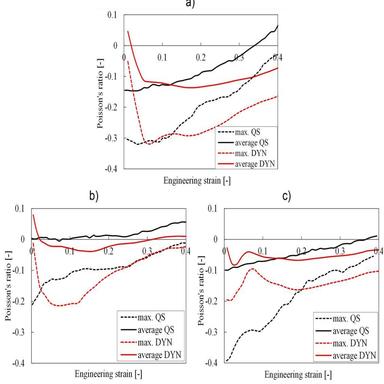
Maximum and average Poisson's ratio to engineering strain relationships for a) ACS_V1, b) ACS_V2_RD6 and c) ACS_V2_RD9 at different loading velocities.